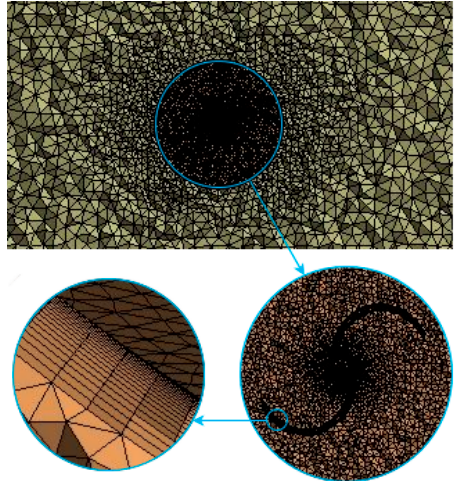
Figure 6. Mesh generation and distribution around Savonius rotor.